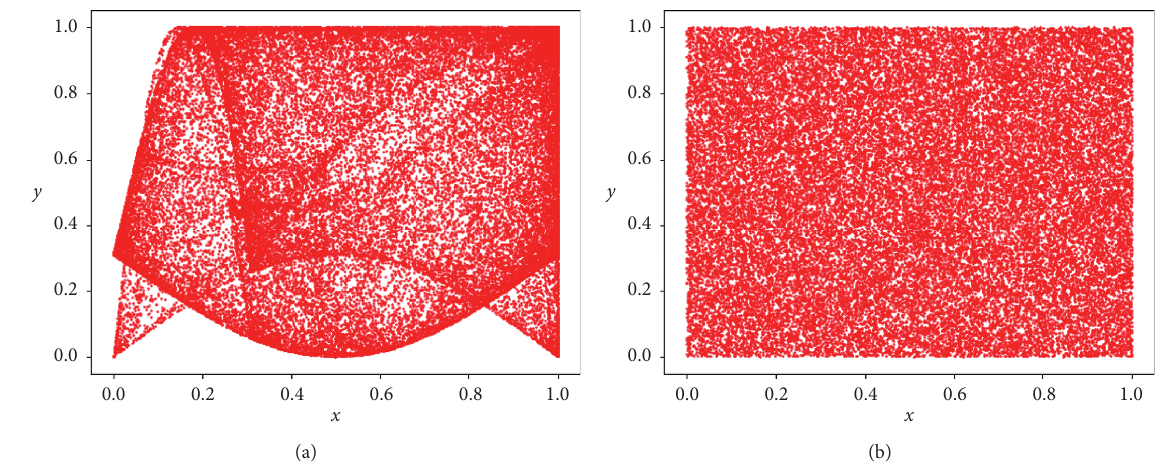
Figure 4: Trajectories of (a) 2D-LSCM and (b) N2D-LSCM.